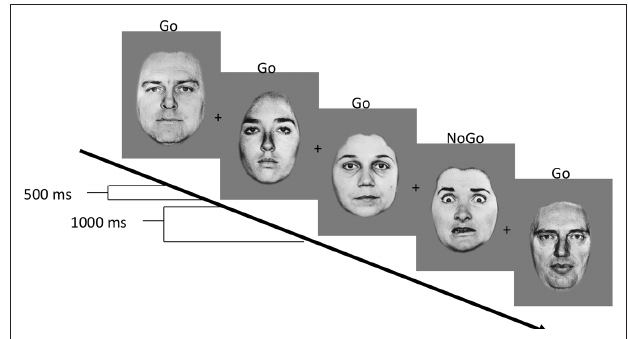
Figure 1 | illustration of task. In this example, neutral faces are the “go” stimulus, and fear faces are the “nogo”